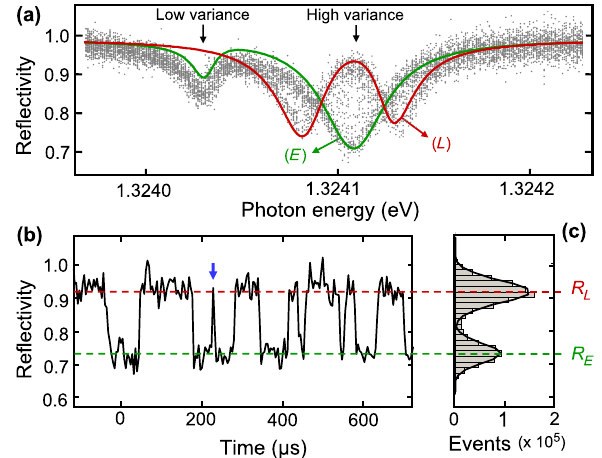
FIG. 2. (a) Scatter plot of measured reflectivity values versus photon energy at T ¼ 34 . 1 K and P 0 ¼ 1 . 7 nW. Solid lines: theoretical fit. (b) Real-time reflectivity signal at T ¼ 34 . 1 K, P ¼ 5 . 5 nW, and ω ¼ 1 . 32411 eV. Dashed horizontal lines are 0 guides to the eye indicating the two states with reflectivities R L and R E . (c) Histogram of the reflectivity values measured in the exper- imentalconditionsofFig.2(b).Solidline:numericalfitwithasumof two Gaussian distribution functions centered around R L and R E